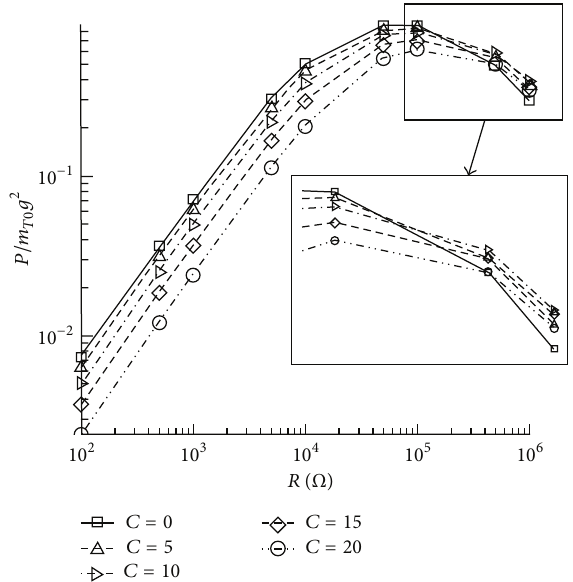
Figure 13: Tapering and electric resistance effects on unimorph.